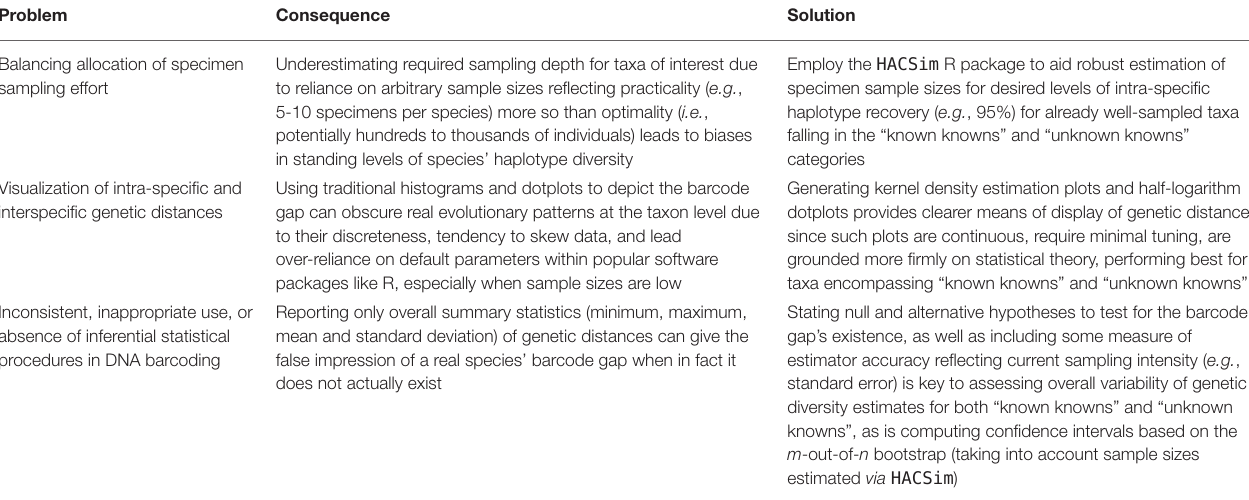
TABLE 1 | Summary of problems, consequences and solutions contributing to the lack of statistical rigor in DNA barcoding as it pertains to accurately estimating the DNA barcode gap at the species level. Problem Balancing allocation of specimen sampling